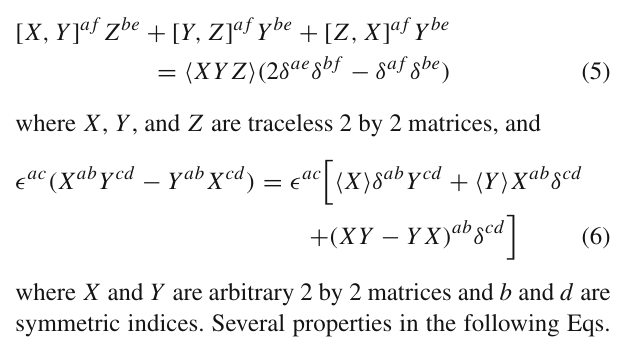
Table 2 The O ( p 2 ) chiral-invariant Lagrangians L π NN , L π qq , L π(cid:2)(cid:2) , and L π N (cid:2) . ψ in L π NN /π qq means N /ψ q of Eq. (1) and (cid:9)···(cid:10) means traceinflavorspace.The symbol [···] + standsfor [···]+ h . c . .Weuse i